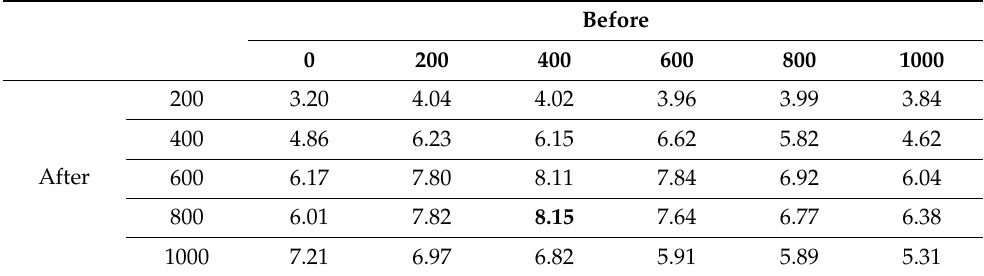
Table 3. The perceived naturalness of Pepper. The bold text with a large font means the highest value.